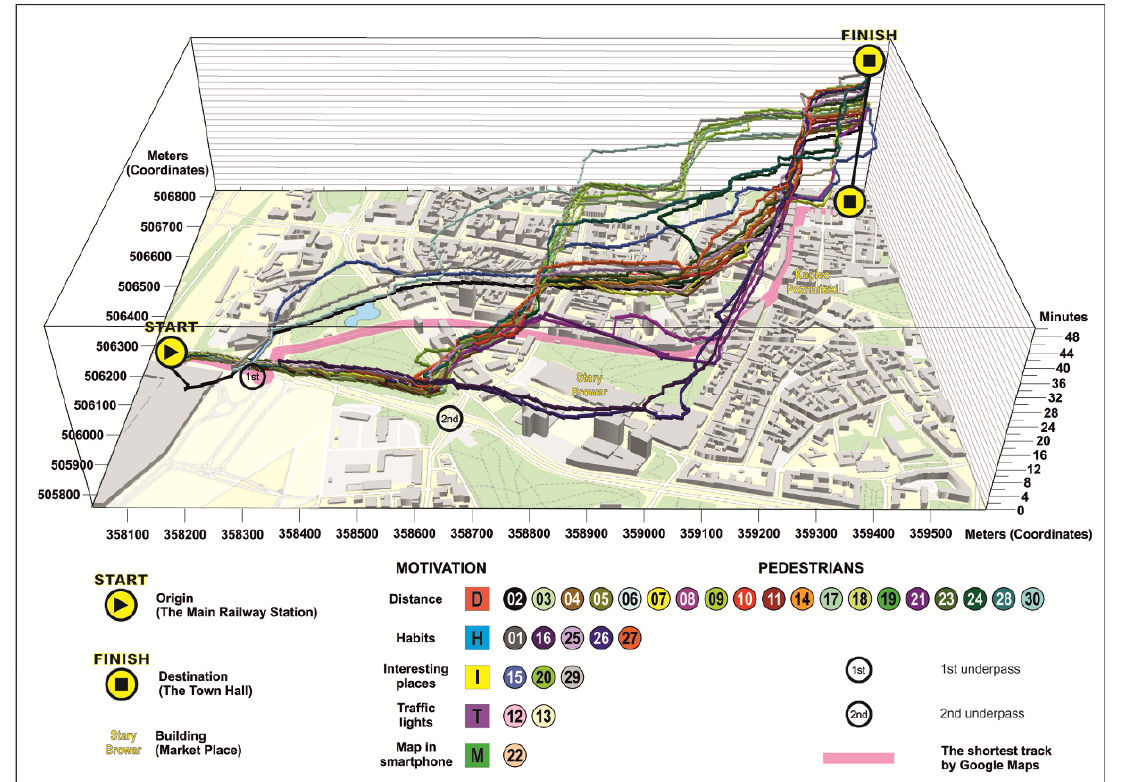
Figure 6. Space–time cube with trajectories (space–time paths).